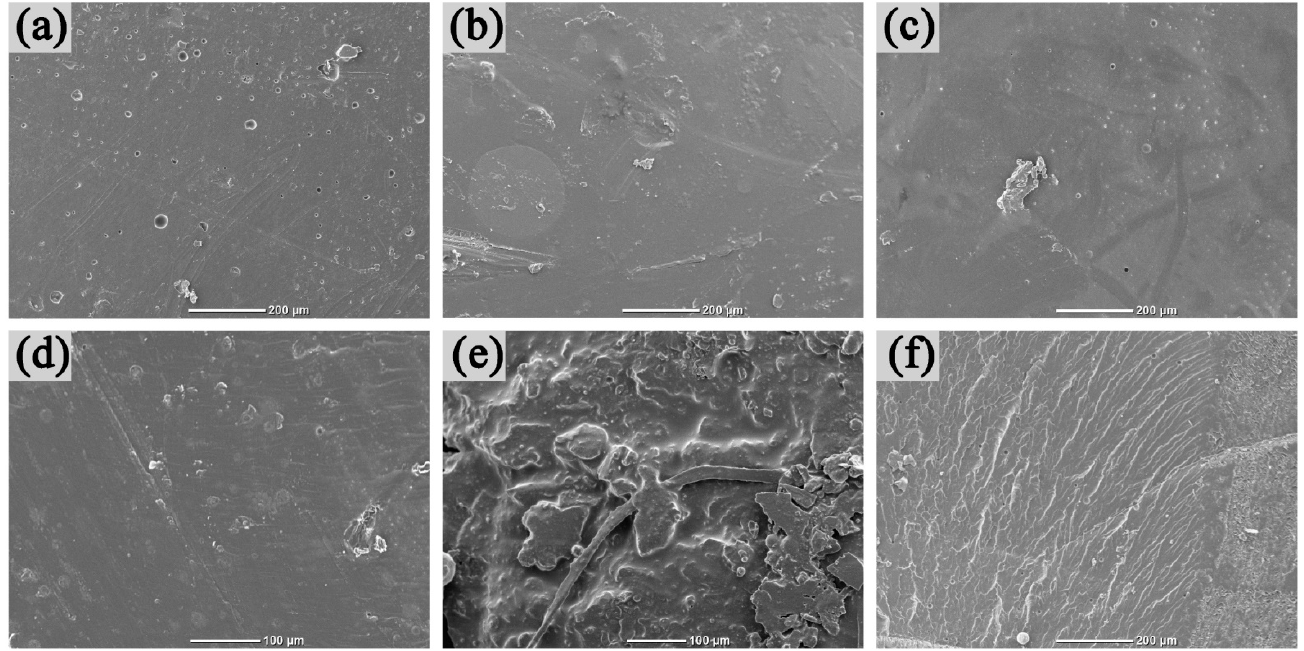
Figure 2. SEM topography of resin: ( a ) Epoxy surface, ( b ) Modified epoxy surface, ( c ) Ternary resin surface, ( d ) Epoxy fracture surface, ( e ) Modified epoxy resin fracture surface, ( f ) Ternary resin fracture surface.